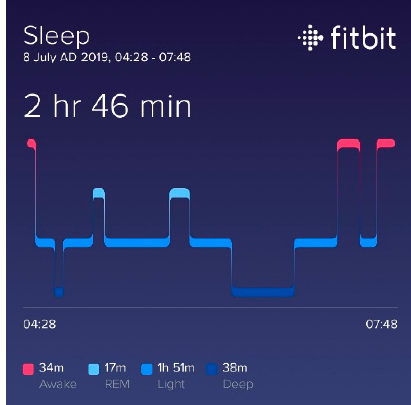
Figure A11. Bangkok, Thailand.